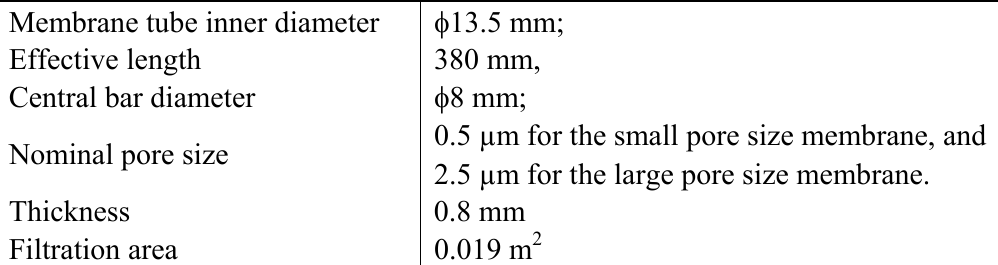
Table 1. Dimensions of two membrane